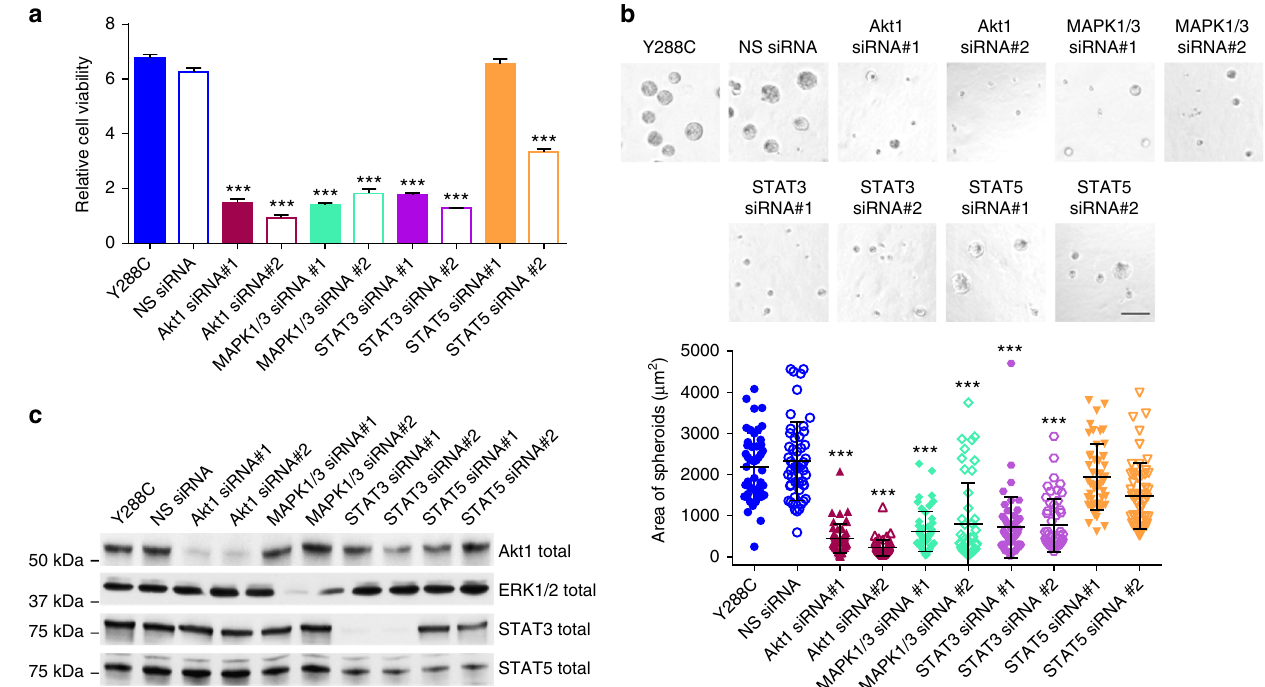
Fig. 5 Y288C promotes cell proliferation through Akt, ERK1/2, and STAT3. MCF10A cells stably expressing Y288C was transfected with siRNA speci fi cally target, Akt1 , MAPK1/3 , STAT3 , or STAT5 , respectively. a The knockdown ef fi ciency was veri fi ed by western blot 48 h after transfection. 24 h after transfection, cells were trypsinized, counted and plated for b cell viability assay (Student ’ s t -test) and c 3D growth in growth factor-reduced Matrigel for 4 days. The relative cell viability of three independent replicates was assessed with Prestoblue 4 days after transfection. Bar, 100 μ m. The area of 50 spheroids are presented as mean ± SD (Dunnett ’ s multiple comparisons test). *** p <